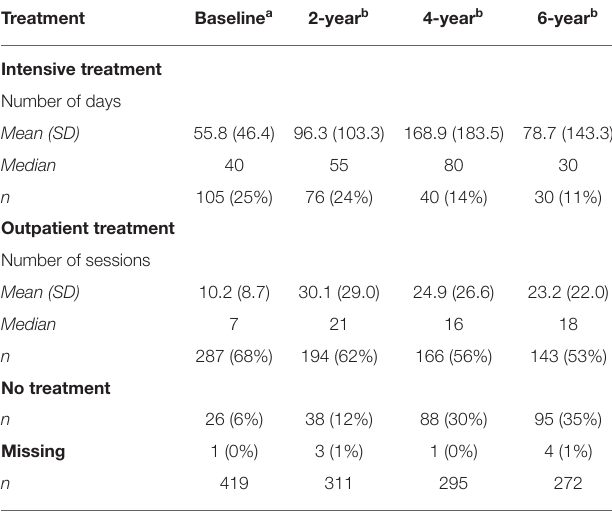
TABLE 2 | Treatment of patients with OCD over the course of 6 years.